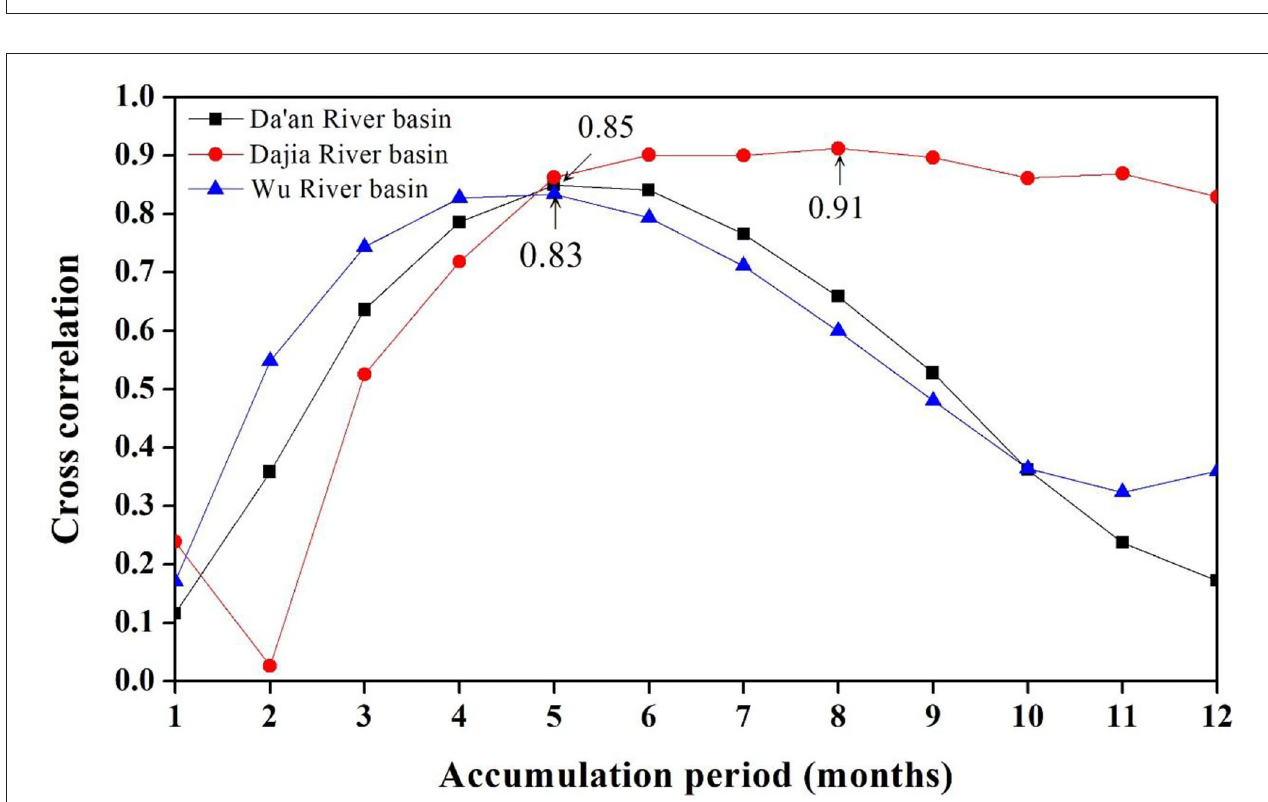
FIGURE 9 | Cross-correlation function of SPI and SGI for various